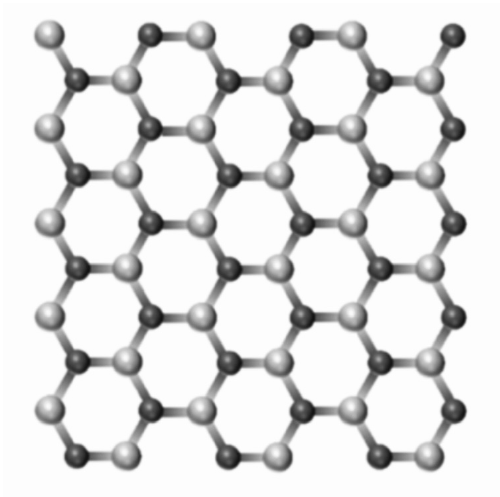
Figure 1. Two-dimensional